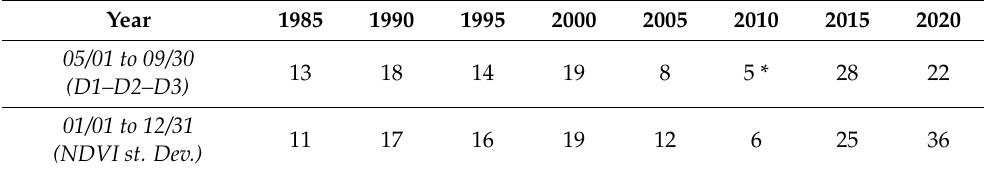
Table 2. Number of images in the collections for each year of sampling. The time span for the reflectance band and indices ranges from 05/01 to 09/30 of each sampling year, while the standard deviation of the NDVI was measured on all images (cloud cover < 15%) in the time span from 01/01 to 31/12 of the sampling year.